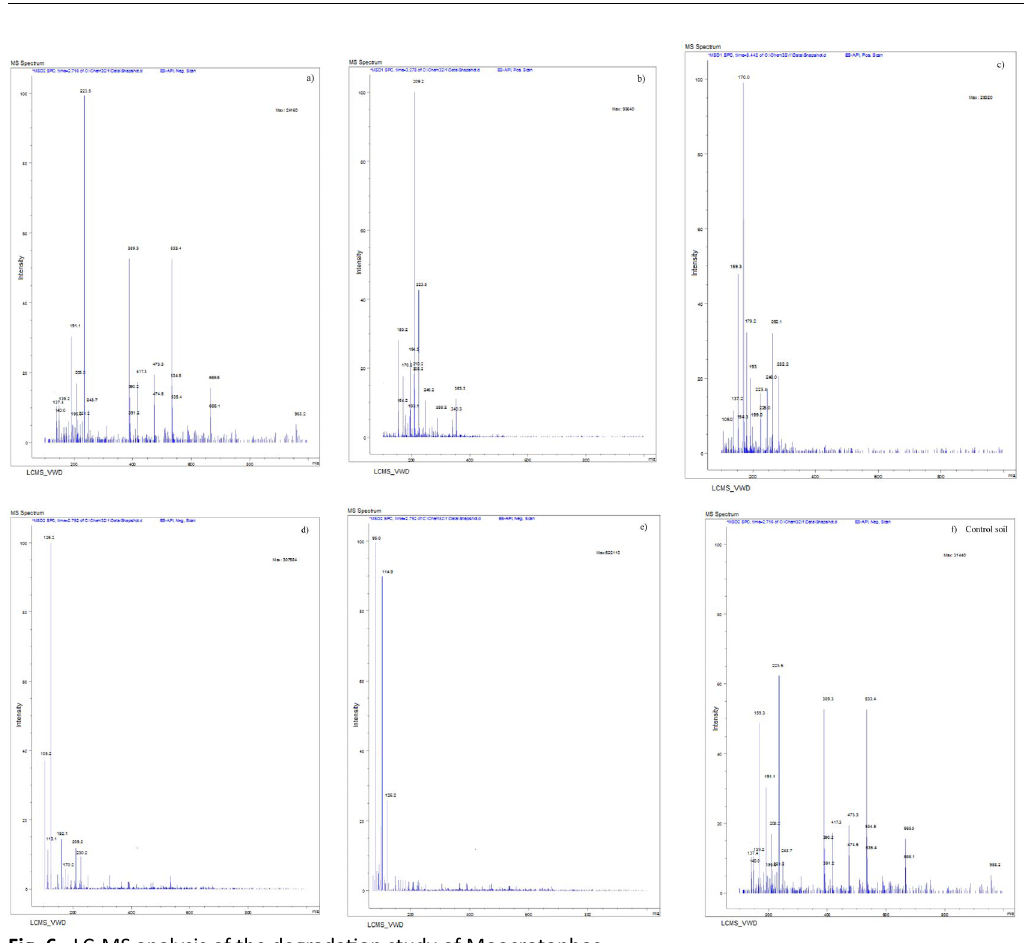
Fig. 6. LC-MS analysis of the degradation study of Moocrotophos a. 0 th h, b. 4 th days, c. 8 th days, d. 12 th days, e. 16 th day, f. 16 th day Control